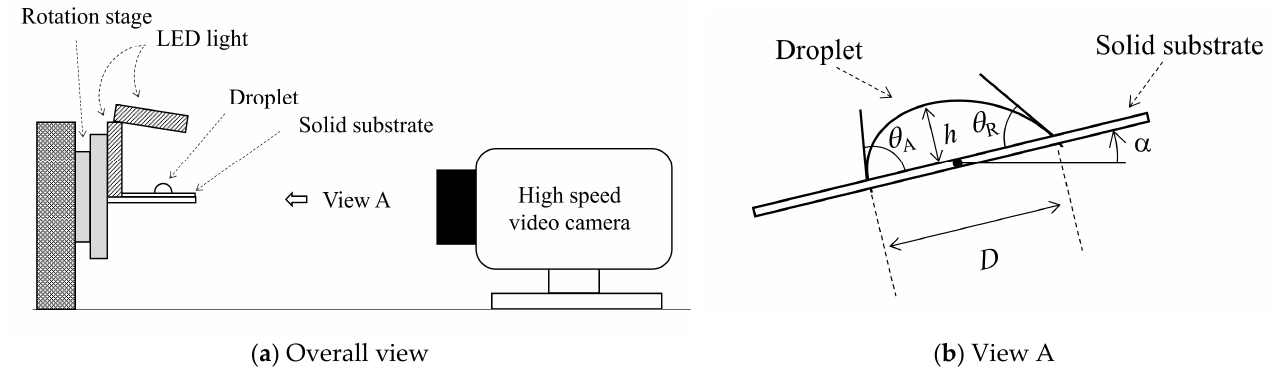
Table 1. Droplet volumes, initial contact area diameter and droplet height in each liquid used in sliding experiment.